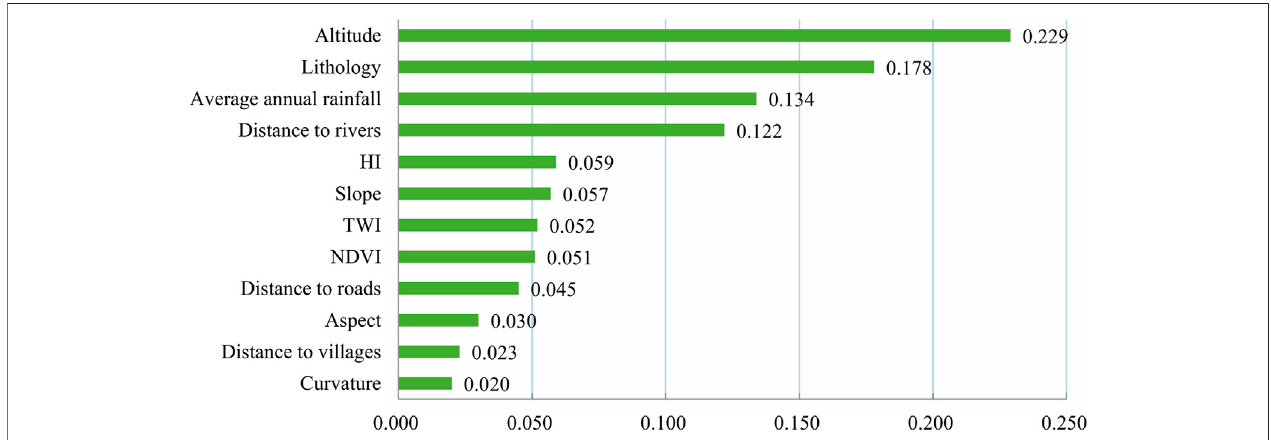
FIGURE 11 | Importance of in fl uencing factors based on the RF